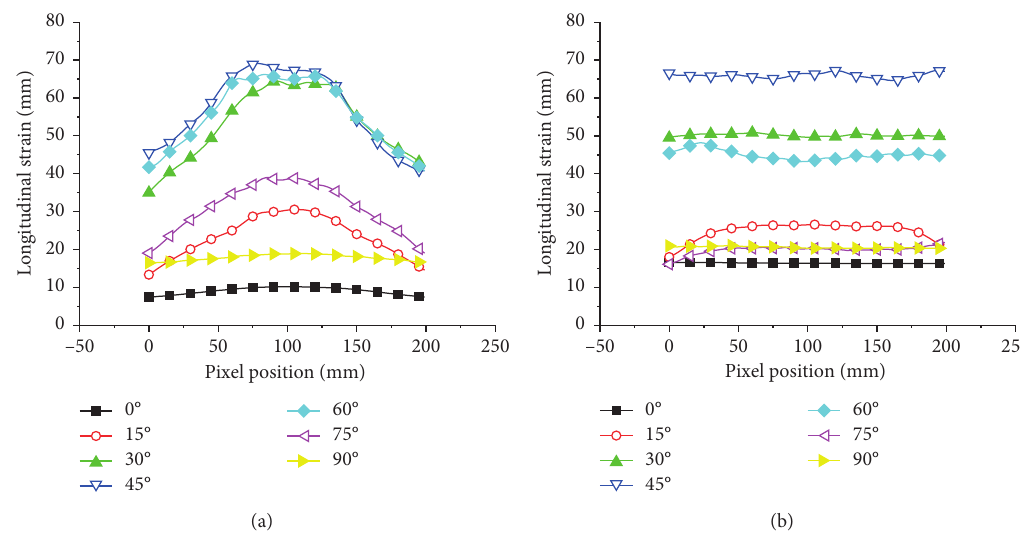
Figure 6: Relationship between the longitudinal ultimate strain and the pixel position. (a) Dumbbell shape. (b) Strip